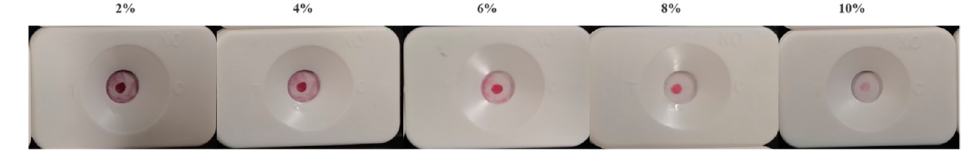
Figure 11. The result diagram of optimizing the content of Tween-20 comprehensive buffer.